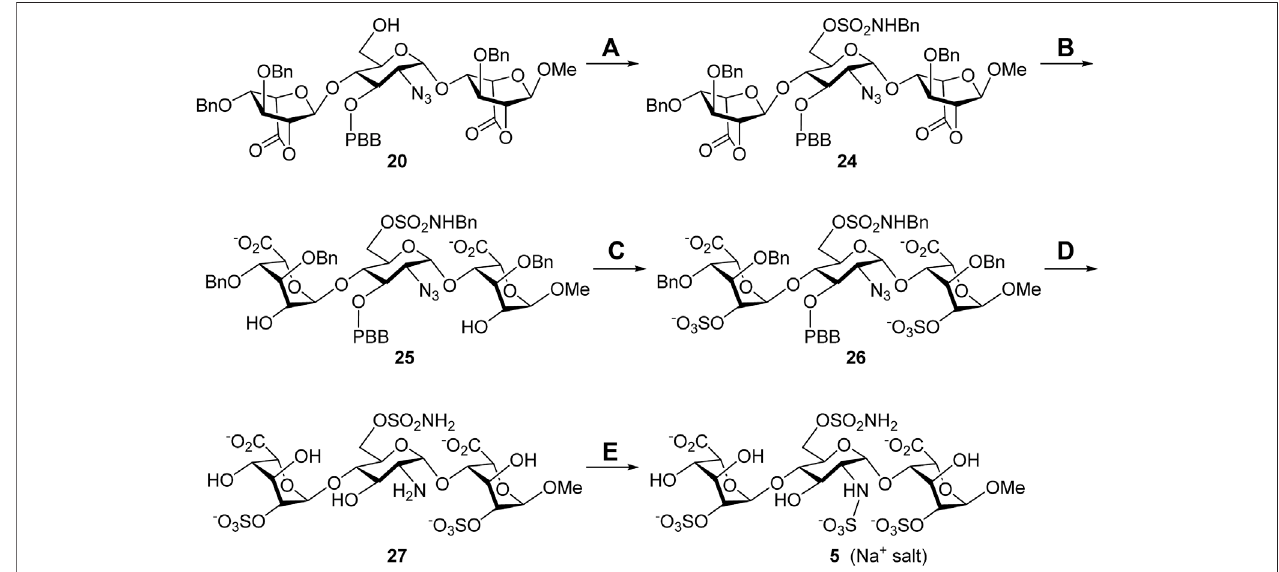
SCHEME 3 | Synthesis of the 6 ′ - O -sulfonamide trisaccharide inhibitor 5 . Reagents and conditions: (A) ClSO 2 NHBn, pyridine, RT, 15 min, 78%; (B) 1 M LiOH (aq) , (cid:129) THF, RT, 1 h, 90%; (C) SO 3 Et 3 N, DMF, 65 ° C, 24 h, 70%; (D) Pd(OH) 2 /C, H 2(g) , phosphate buffer (pH = 7.0), MeOH, RT, 48 h, 73%; (E) SO 3 H 2 O, RT, 48 h,